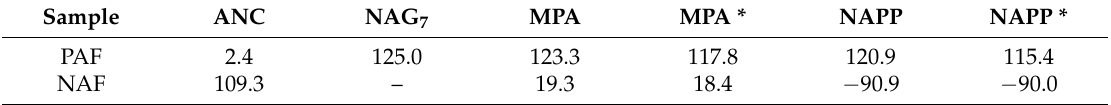
Table 4. ABA and NAG test results of PAF and NAF (in kg H 2 SO 4 t − 1 ).